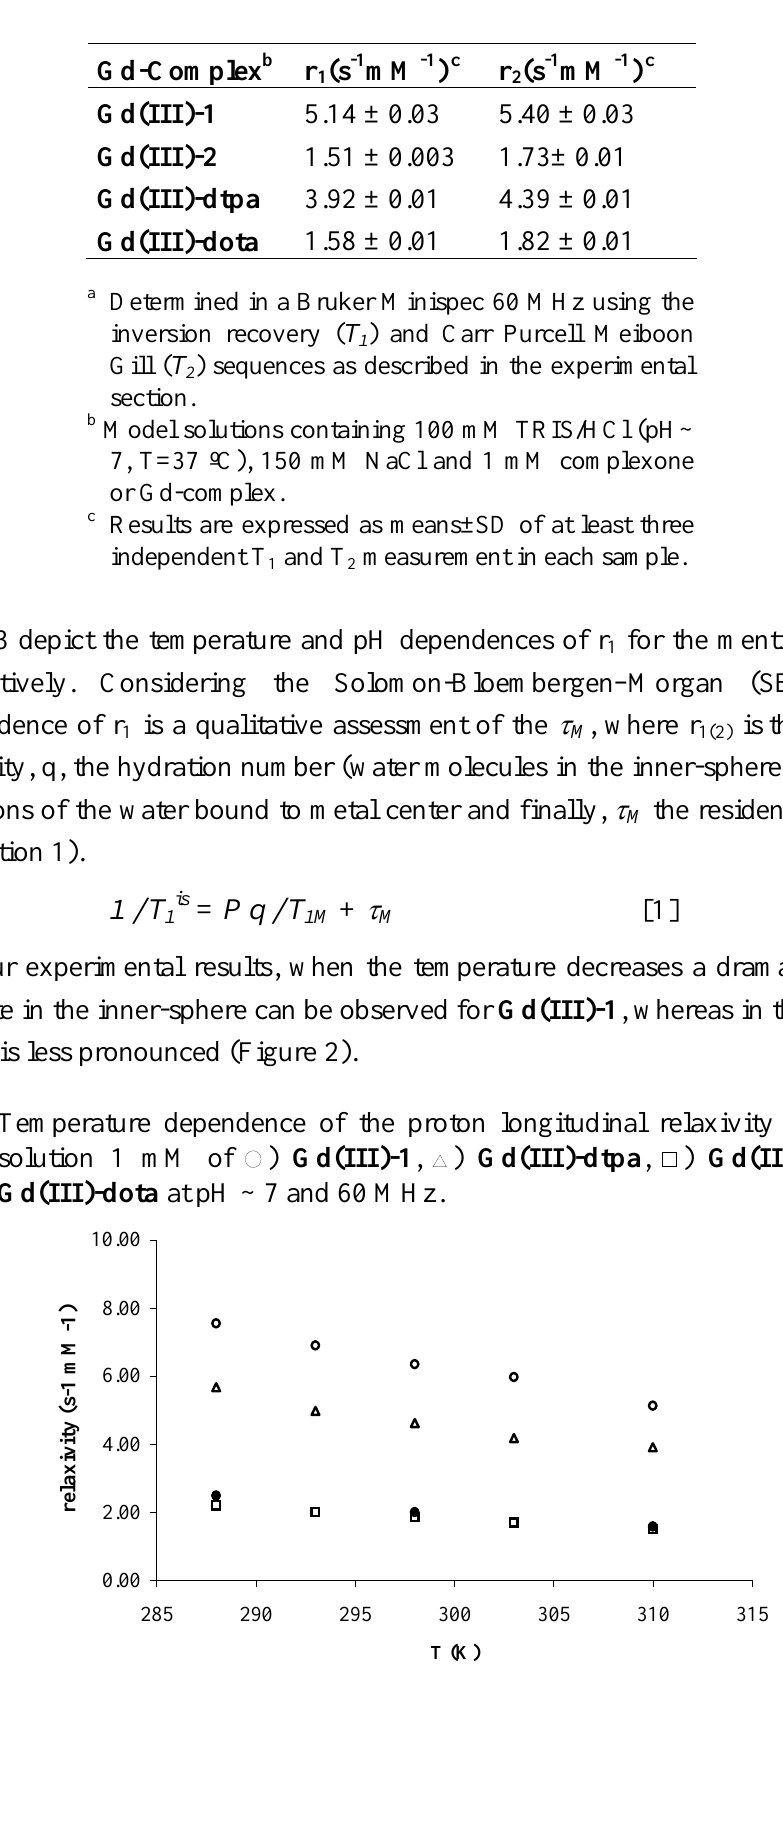
and r ) of aqueous solutions of 1 2